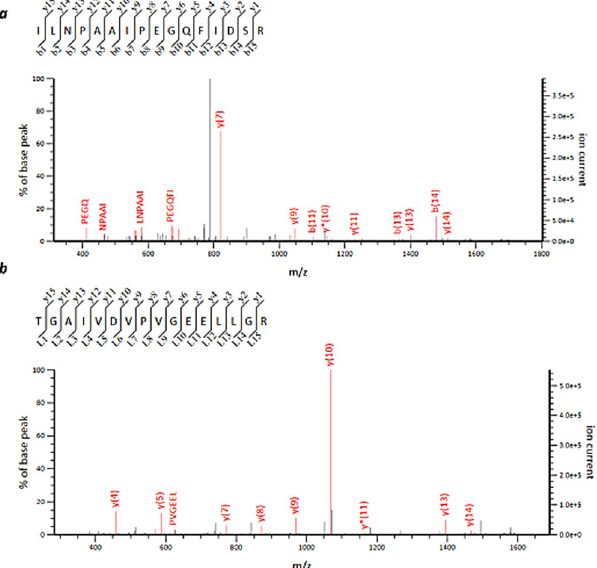
Figure 4. Tandem MS (MS/MS). Tandem mass spectrum of the precursor ion in the infarcted cardiac tissue (sample 1) at ( a ) HBA, m/z 1529, P = 2.6 × 10 − 5 ; ( b ) ATP5A, m/z 1625, P = 6.2 × 10 − 5 ; and ( c ) MYL3, m/z 1396, P = 1.2 × 10 − 2